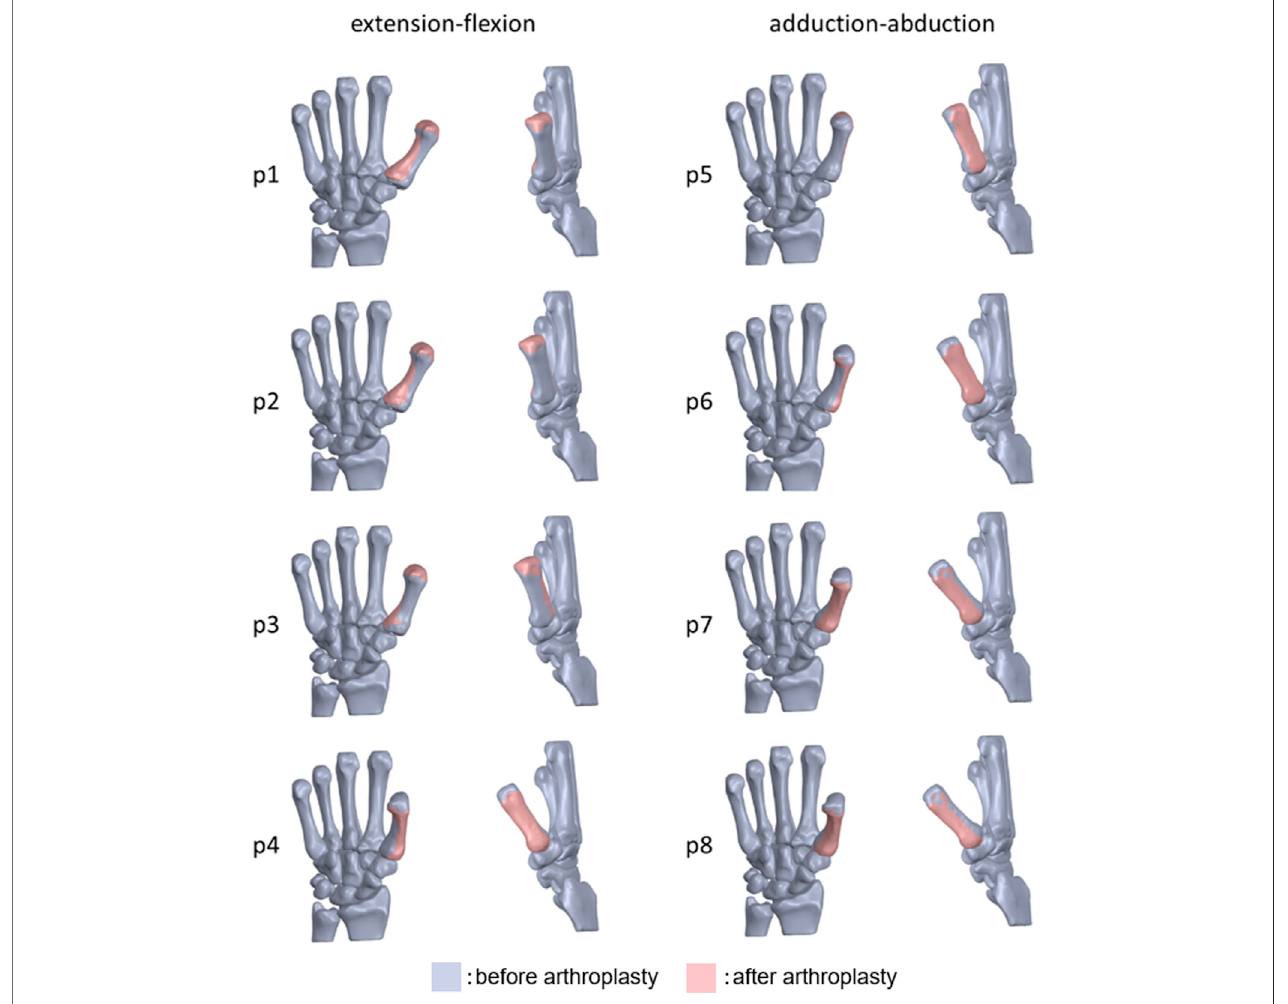
FIGURE 4 | Overlapped 3D bone models of the 1st metacarpal bone before and after arthroplasty of one subject (p1: maximum extension, p4: maximum fl exion, p5: maximum adduction, p8: maximum abduction).